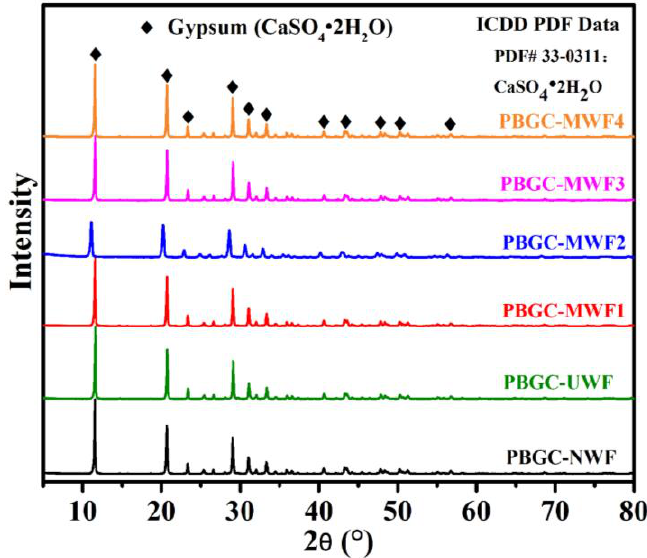
Figure 11. The XRD pattern of all the PBGCs .